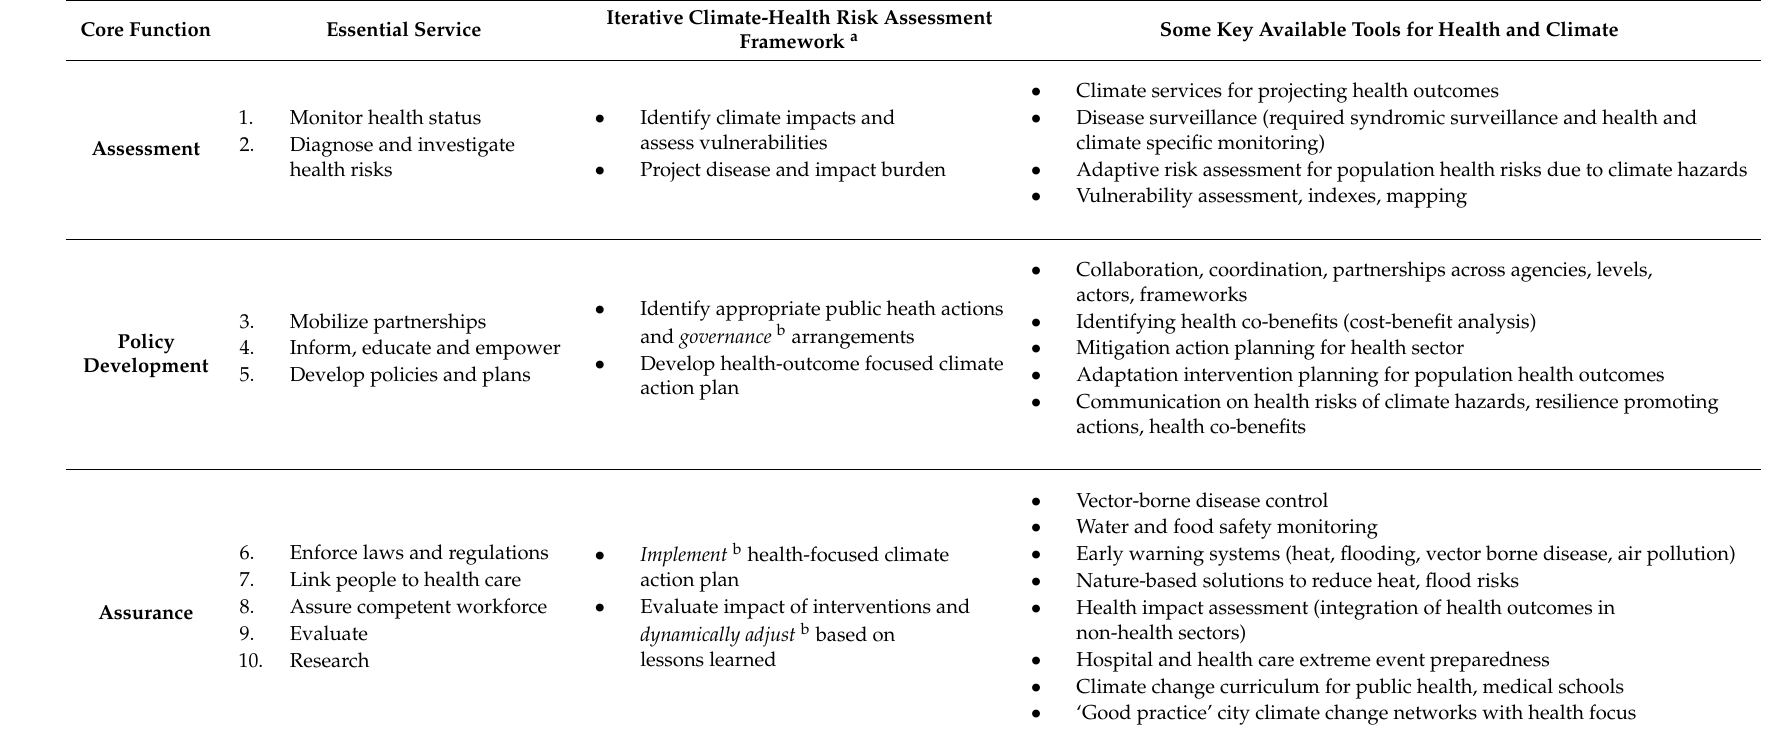
Table 1. Applying the public health core functions and essential services model to climate change. Core